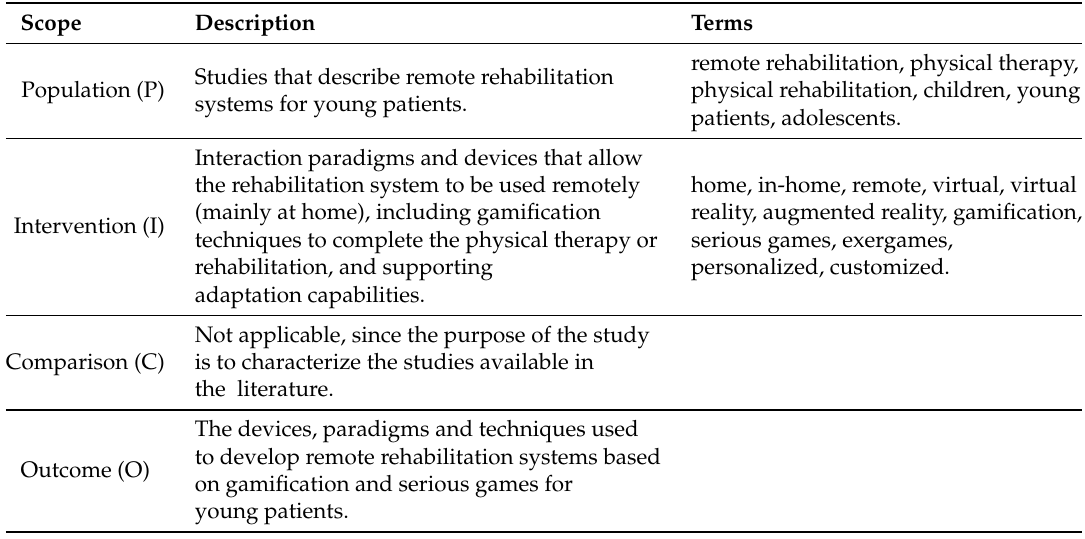
Table 2. Identification of the search terms using the Population (P), Intervention (I), Comparison (C), and Outcomes (O) (PICO)